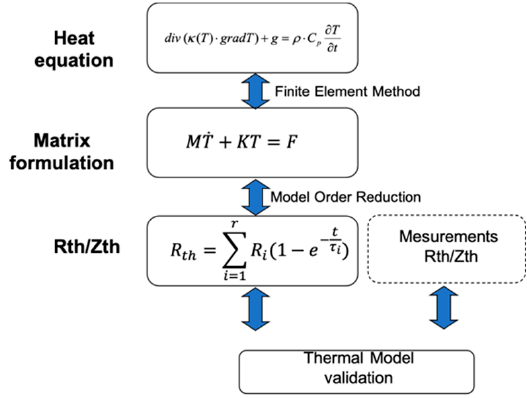
Figure 1 . Extraction flow. Figure 1. Extraction